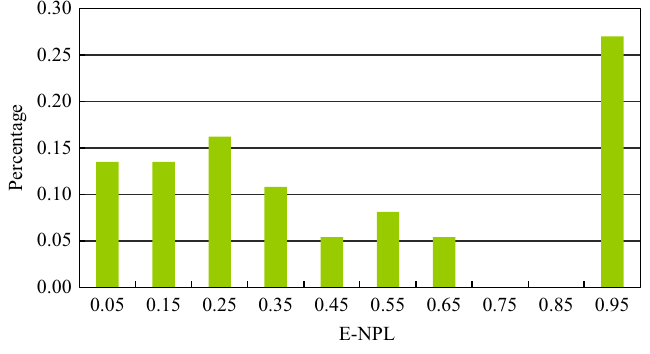
Fig. 1. Distribution of